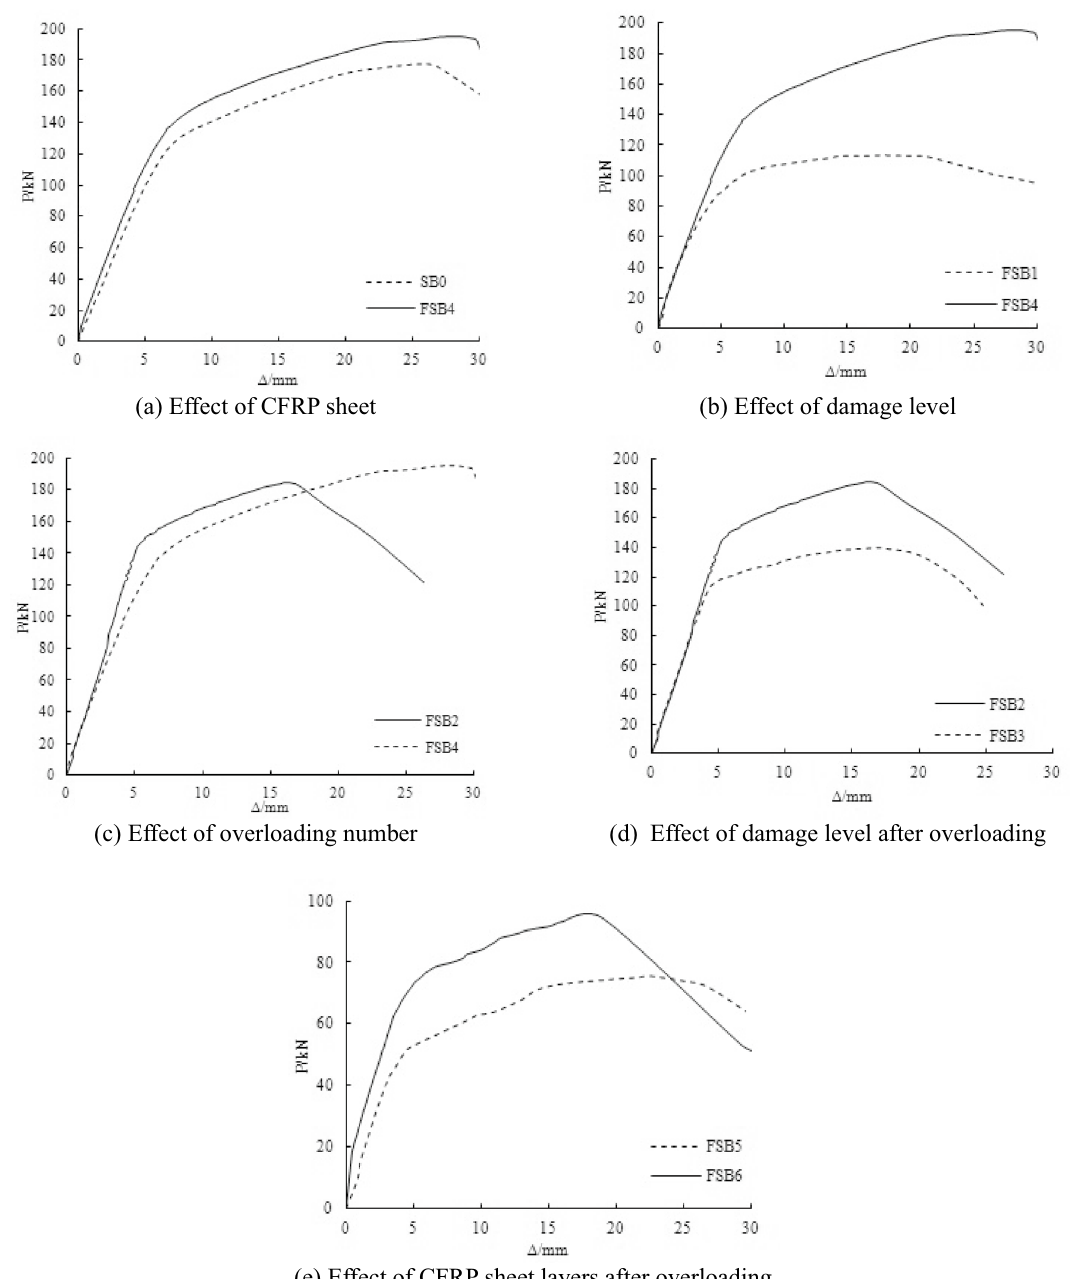
Figure 6. Load–deflection curves of strengthened steel